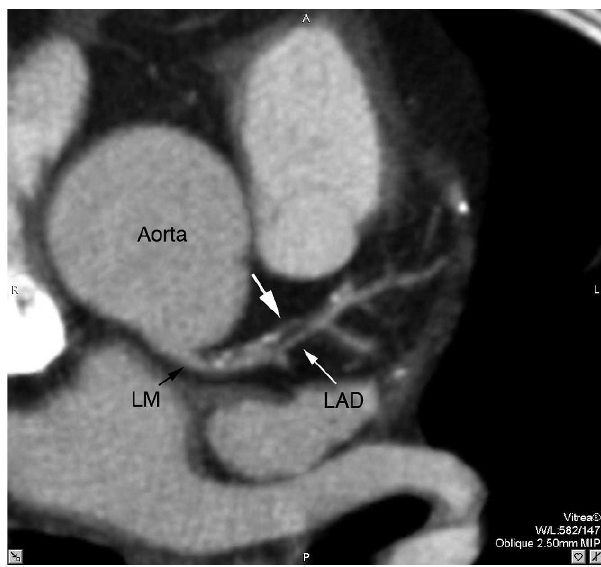
Figure 2 - A coronary-computed tomography angiogram indicat- ing a low-density image in the proximal segment of the LAD that is compatible with a coronary thrombus (white